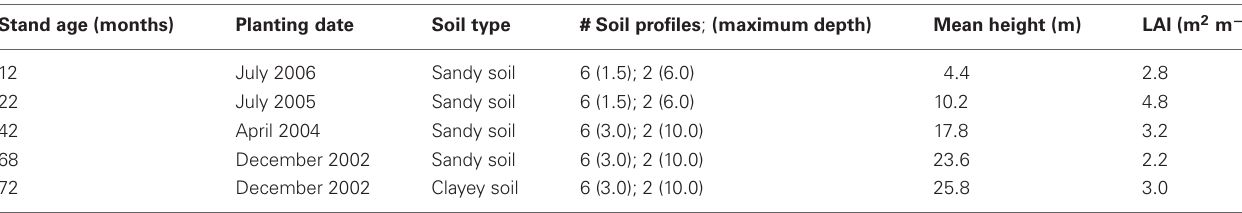
Table 1 | Main characteristics of the stands sampled on sandy soil (chronosequence) and clayey soil. Stand age (months) Planting